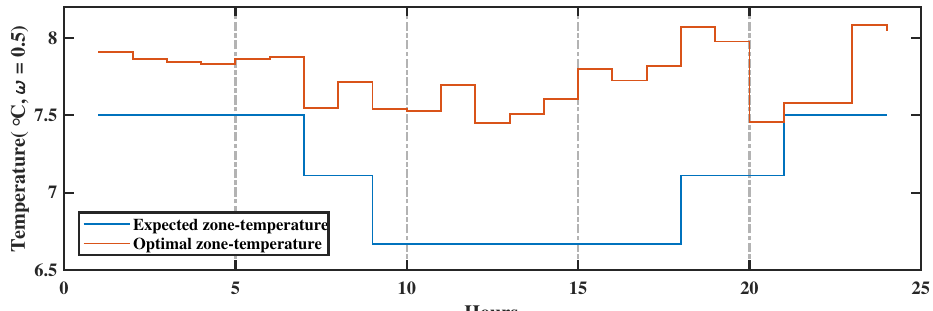
Figure 13. The set-point of zone cooling temperature with ω = 0.5 in case 2.